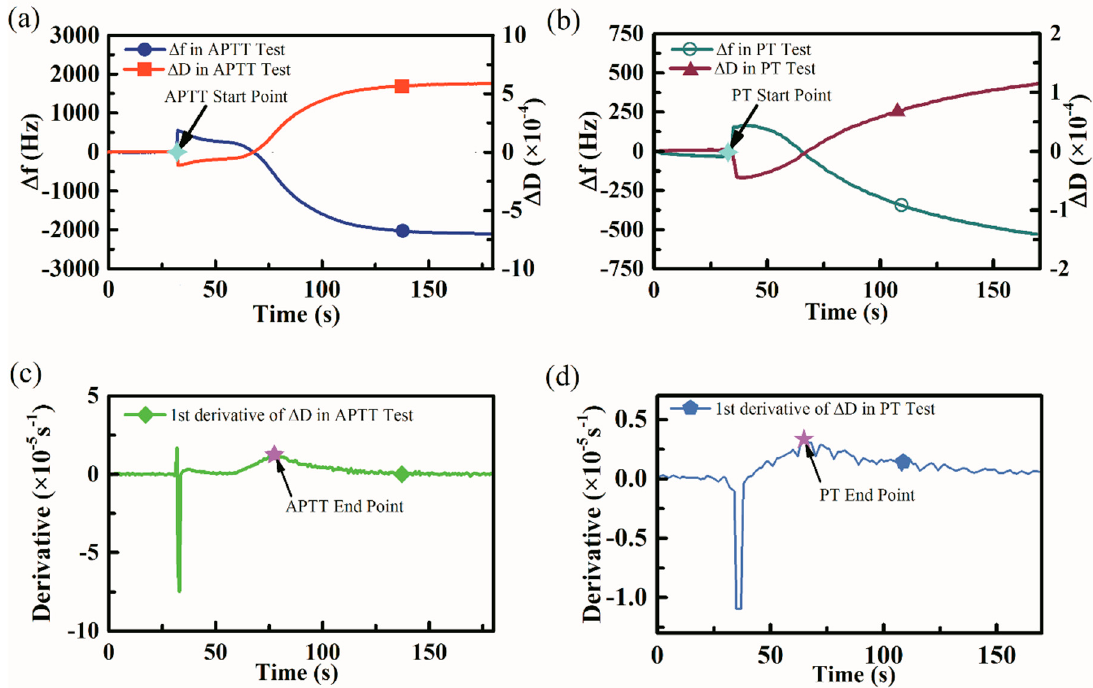
Figure 7. Typical frequency and dissipation signals during blood coagulation, all data were recorded by a smartphone. ( a ) Typical frequency and dissipation curves during activated partial thromboplastin time (APTT) measurements and the APTT start point was considered as the moment when APTT activator was added. ( b ) Typical frequency and dissipation curves during PT measurements and the PT start point was considered as the moment when PT reagent was added. ( c ) The first-order derivative of APTT dissipation curve and the peak point was regarded as the APTT end point. ( d ) The first-order of PT dissipation curve and the peak point was regarded as the PT end